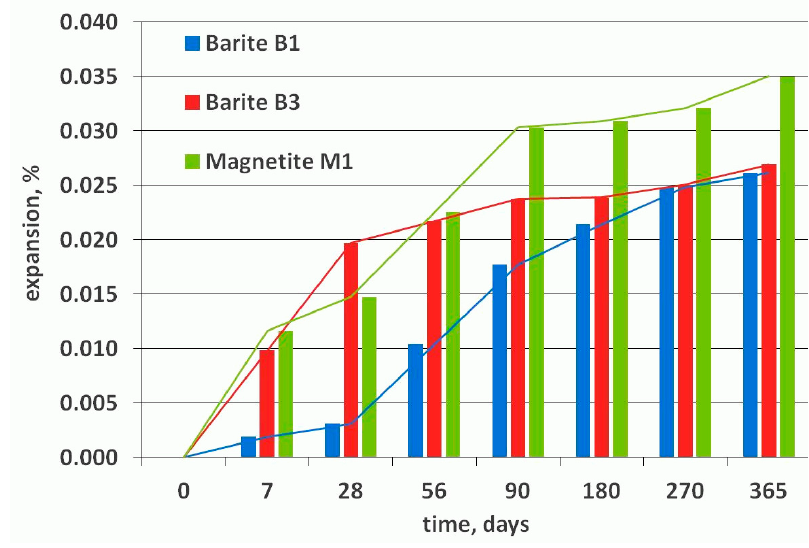
Figure 9. Expansion of concrete prisms stored in high humidity at temperature 38 °C over one year.